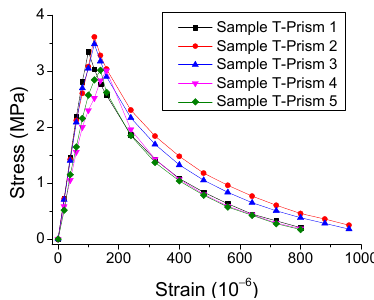
Table 3. Compressive strength f c of cube specimens (MPa).